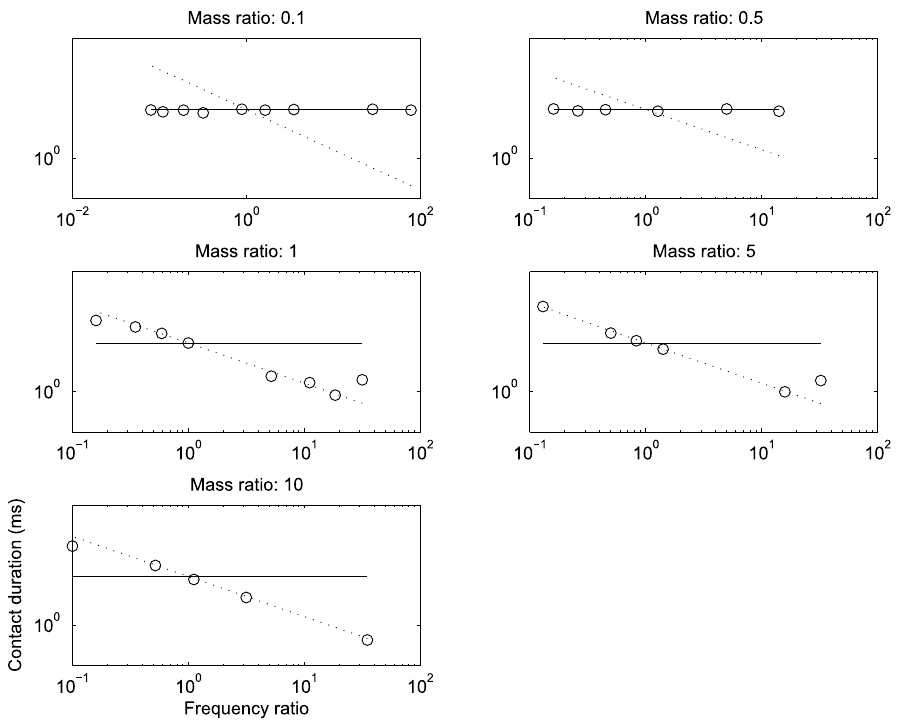
Fig. 8. PF beam against PF beam – Impact duration sensibility: “ ◦ ”: fi rst impact duration; solid line: 1 / 2 T AO PF 1 ; doted line: 1 / 2 T AO PF .